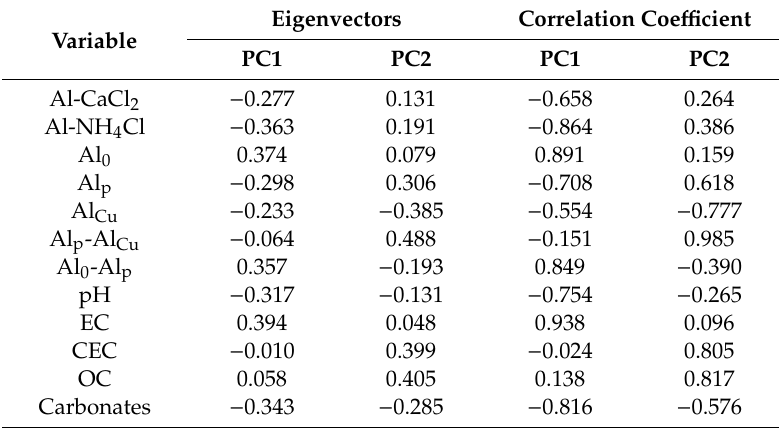
Figure 3. Principal component analysis for soil aluminium fractions and chemical properties of manure (PM) and its biochars (BPC450 and BPC600) and hydrochars (HPC200 and HPC240). Table 3. Eigenvectors and correlation coefficients between principal components (PC1 and PC2) and variables (soil Al fractions and chemical properties of the amendments).